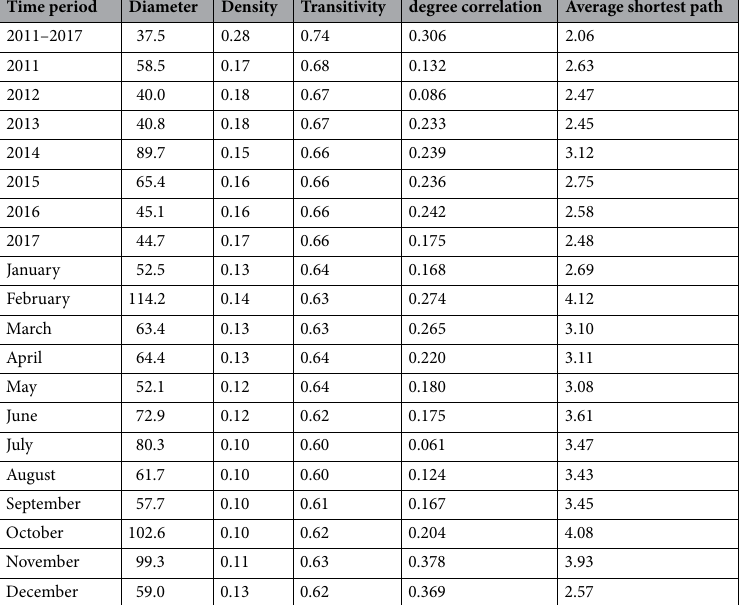
Table 2. Network indices (Diameter, density, transitivity, degree correlation, average shortest path) calculated from the networks covering the Mediterranean region and estimated in three temporal contexts: the entire period 2011–2017, yearly time periods from 2011 to 2017 and monthly time